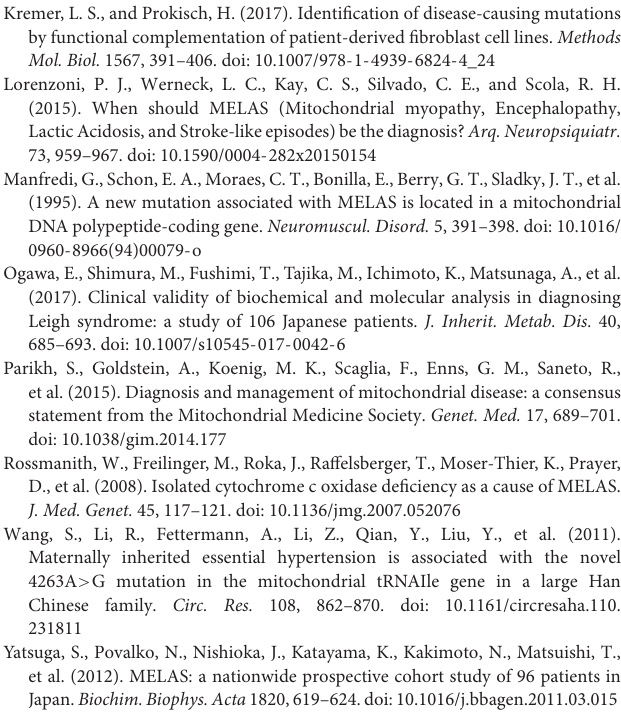
Supplementary Table 1 | List of all the variants in mtDNA sequencing for the